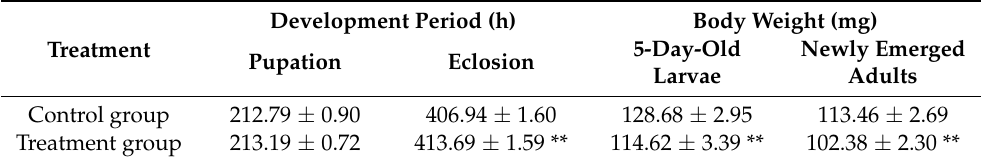
Table 2. Effect of antibiotics on development period and body weight of honeybee larvae.